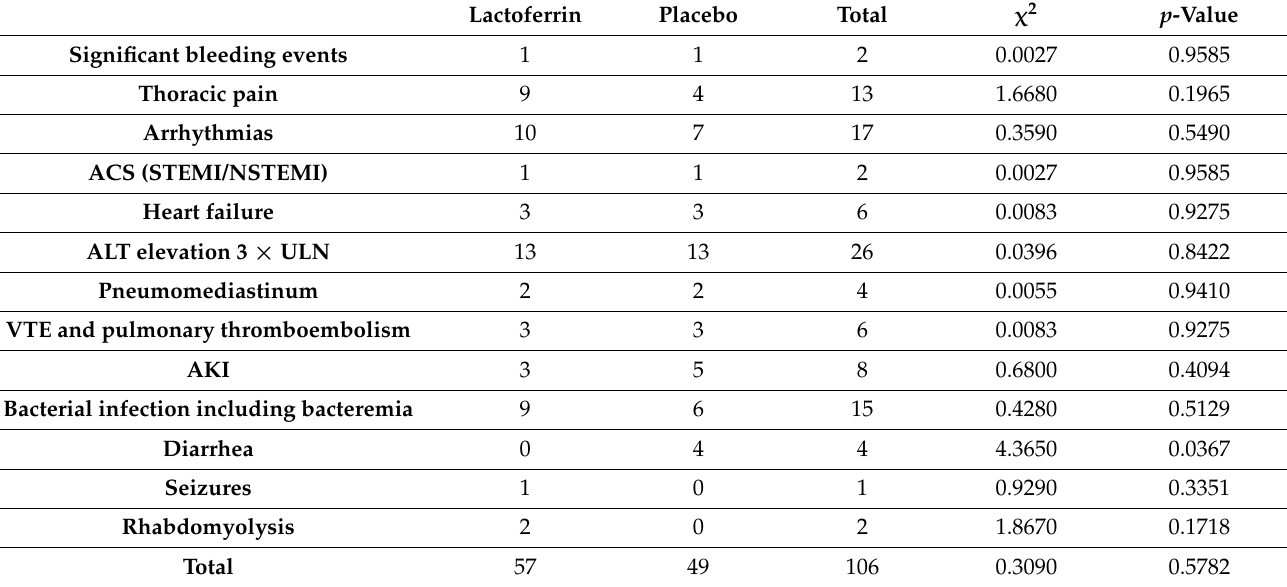
Table 6. Adverse events in the two treatment